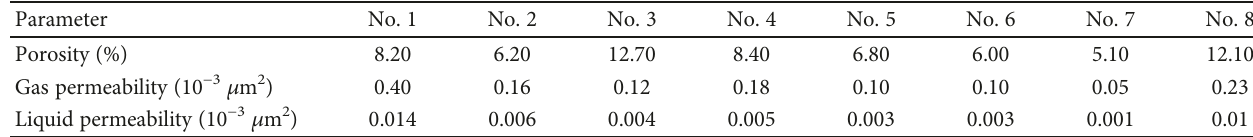
Table 1: Reservoir parameters of Yanchang Formation.